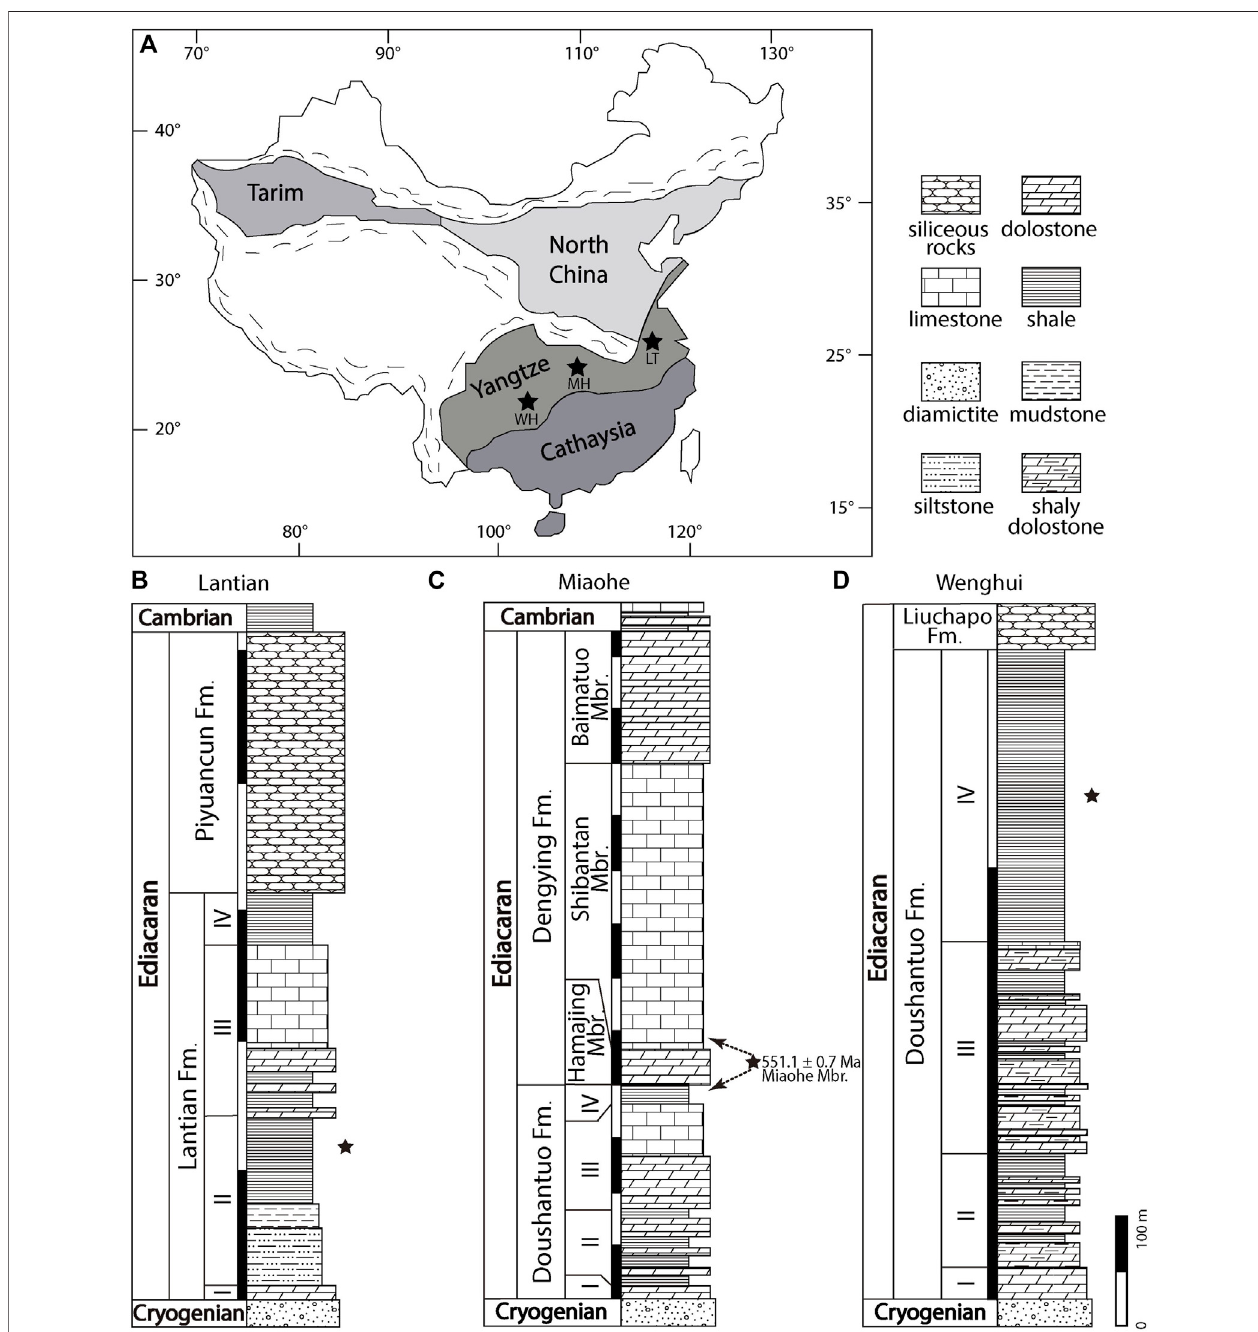
FIGURE1 | Map and stratigraphic columns ofthe study areas. Modi fi ed from Wan et al. (2020) and Wang Y. et al. (2020). (A) Map showing fossil localities: Lantian (LT), Miaohe (MH), and Wenghui (WH). (B-D) Stratigraphic columns of Lantian, Miaohe, and Wenghui, respectively. Stars mark the fossil horizons in (B-D) . Dashed arrows mark alternative correlations of the Miaohe Member. Fm. (cid:1) Formation; Mbr. (cid:1) Member.